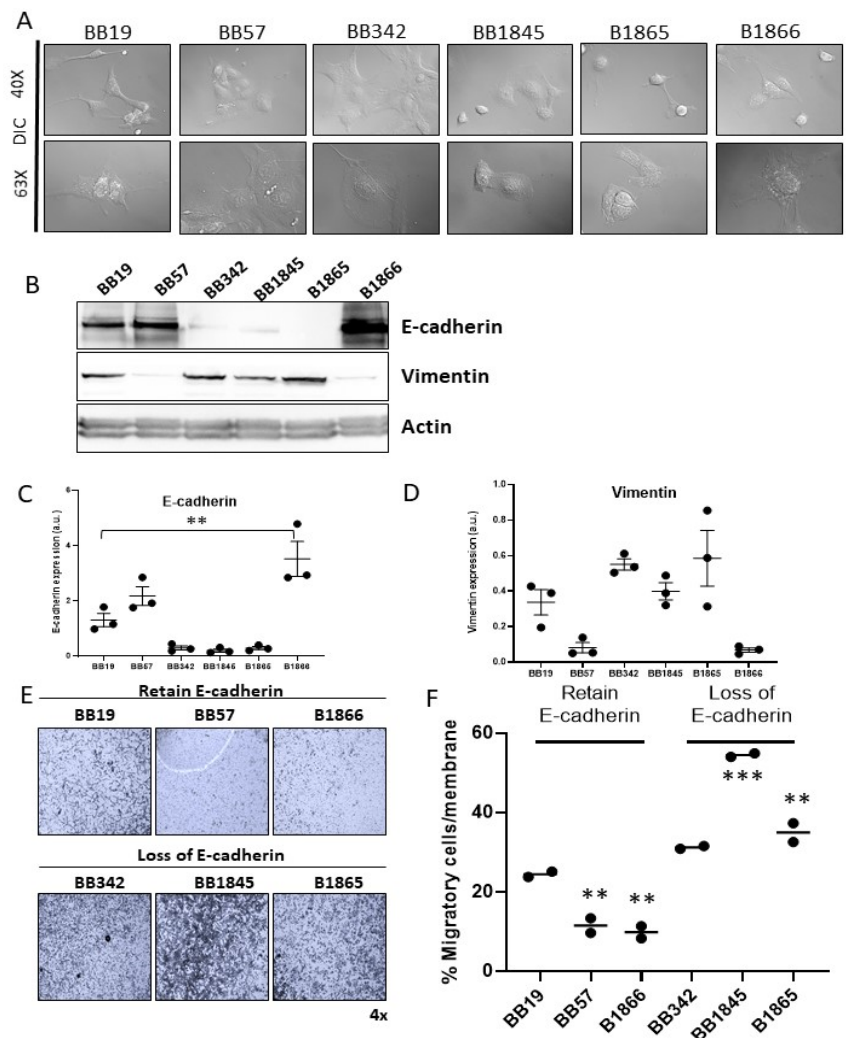
Figure 3. Characterization of epithelial and mesenchymal features of Braf V600E cell lines. ( A ) Repre- sentative differential interference contrast (DIC) images of each cell line. Top: DIC imaging of live cells at 40×. Bottom: DIC imaging of live cells at 63 ×. ( B ) Western blot analysis of levels of epithelial (E cadherin) and mesenchymal (Vimentin) proteins. ( C ) Quantitation of E cadherin expression in each of the six cell lines N = 3, ** p < 0.002 compared to levels in BB19. ( D ) Quantitation of vimentin expression in each of the six cell lines N = 3. No Statistically different comparison compared to levels in BB19. ( E ) Representative images of cells that have migrated through the membrane of a trans-well, imaged at 4 × magnification. ( F ) Quantification of the cells that have migrated through a trans-well. Percent of the membrane area covered by cells that have migrated through the filter is indi- cated on the y-axis. N = 2 independent experiments. ** p < 0.02 compared to BB19, *** p < 0.0001 compared to BB19.